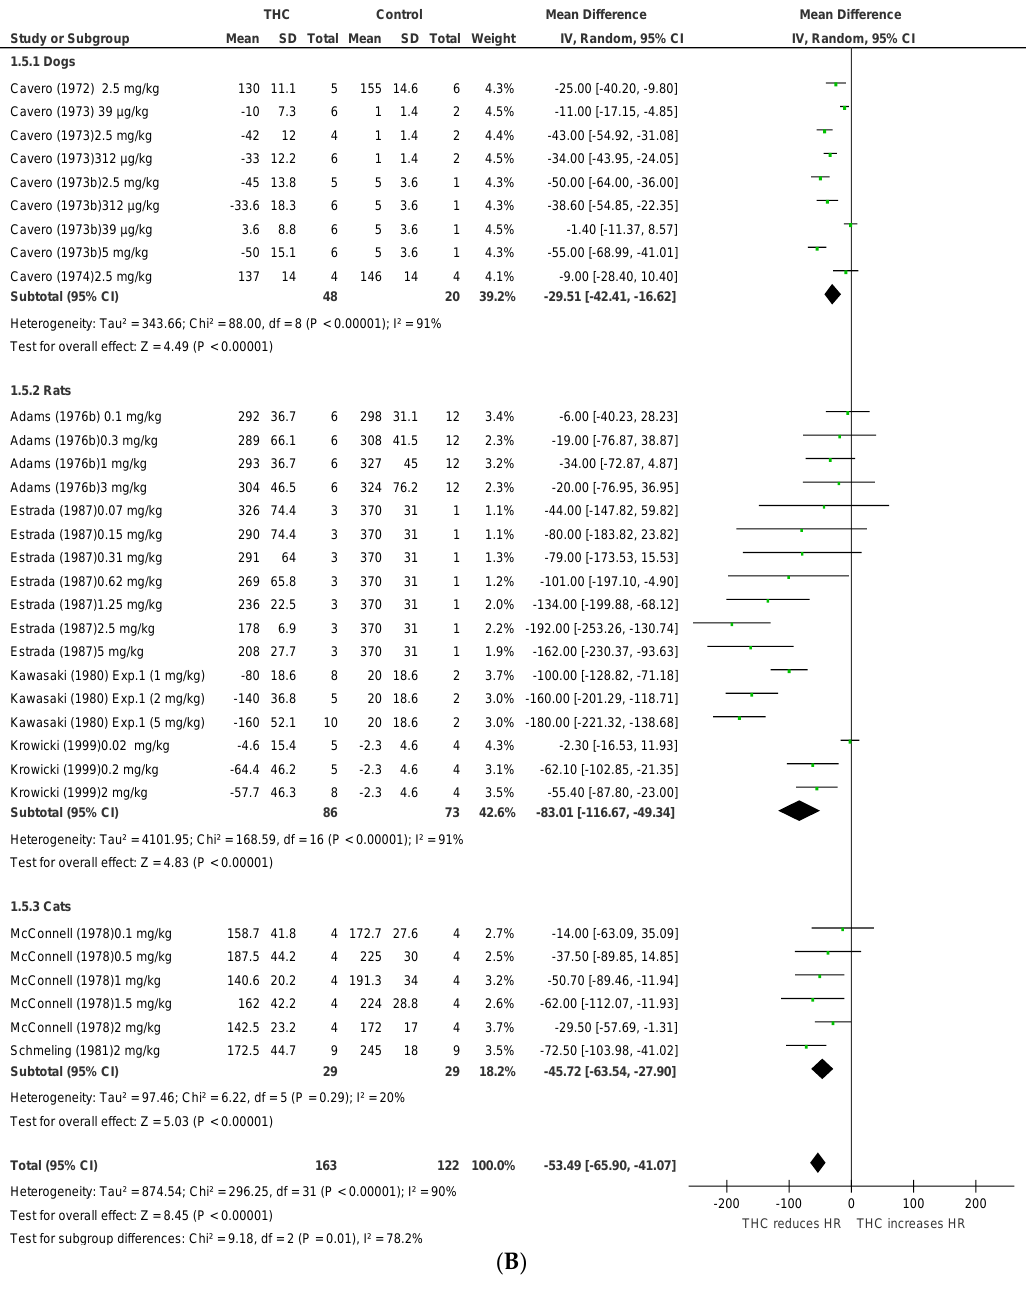
Figure 2. Changes in ( A ) BP and ( B ) HR induced by acute THC dosing in anaesthetised animals. Chronic THC administration (7–35 days) tended to increase mesenteric, femoral, and renal BF ( p = 0.05, Figure 3C) with no significant effect on HR or BP. Heterogeneity was statistically significant for BP and HR measurements after acute THC dosing ( p < 0.00001; I 2 = 90%) and for BP after chronic THC dosing (BP, p = 0.03, I 2 = 72%).